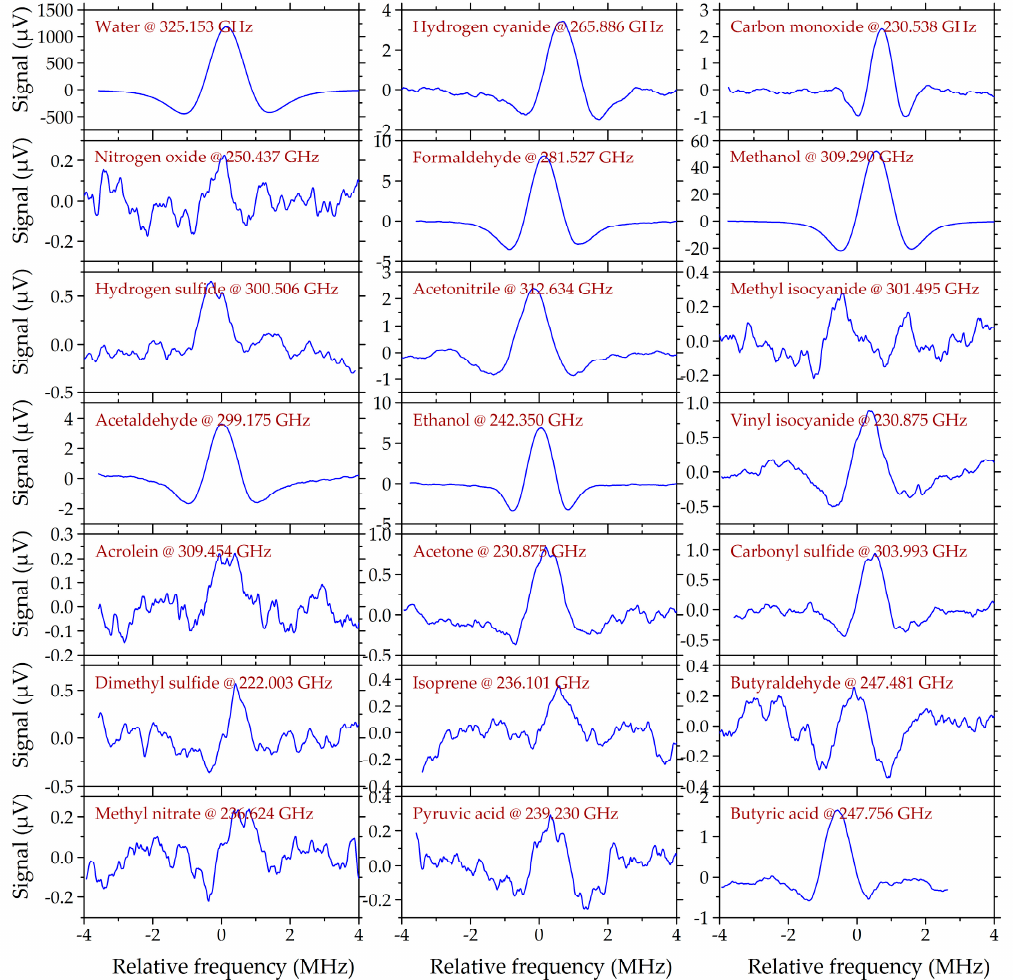
Figure 2. Line scans of the smoker’s sample (P3) with the largest signal for each molecular species. The signal-to-noise ratios range from 1 (acrolein, methyl isocyanide) to 6500 (water). The lock-in phase and the baseline of each scan were processed after the measurements.